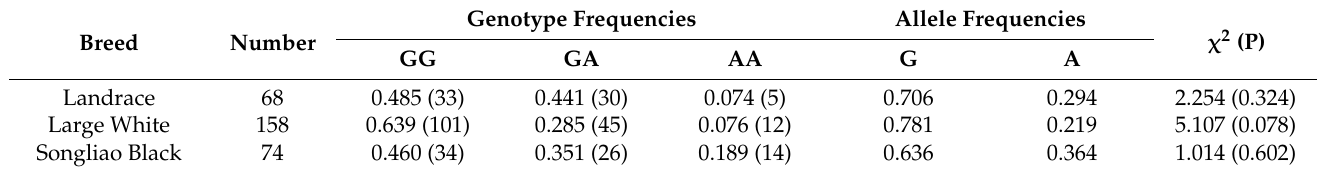
Table 2. Genotype frequencies and allelic frequencies of NK-lysin (NKL) gene in three pig populations.